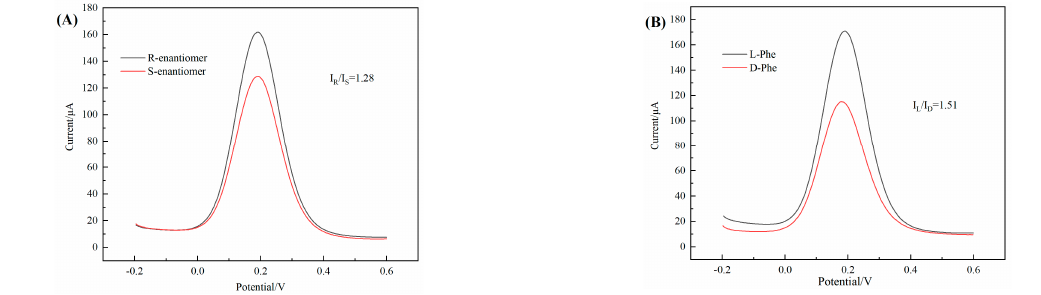
Figure 14. Interaction of di ff erent chiral enantiomers with 3D–rGO–CS–BSA/GCE, ( A ) R–/S–2– amino–1–(4–nitrophenyl)–1,3–propanediol, ( B ) L–/D–Phenylalanine (Phe) in 0.1 M KCl containing 5 mM [Fe(CN) 6 ] 4 − /3 − solution.